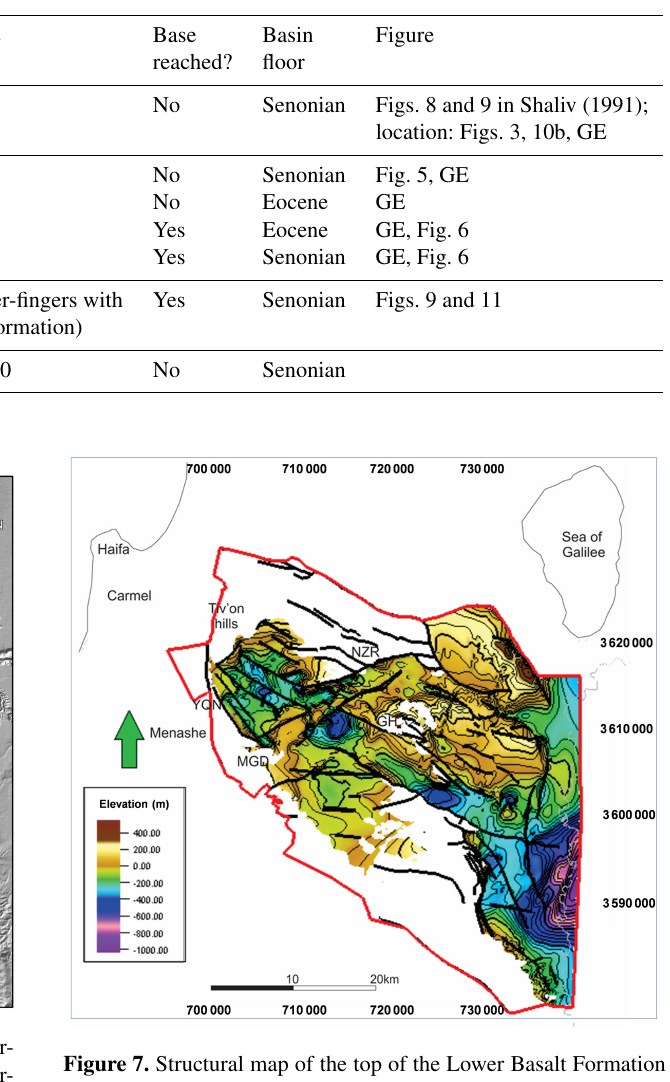
Table 1. Marked thicknesses of the Lower Basalt Fm.